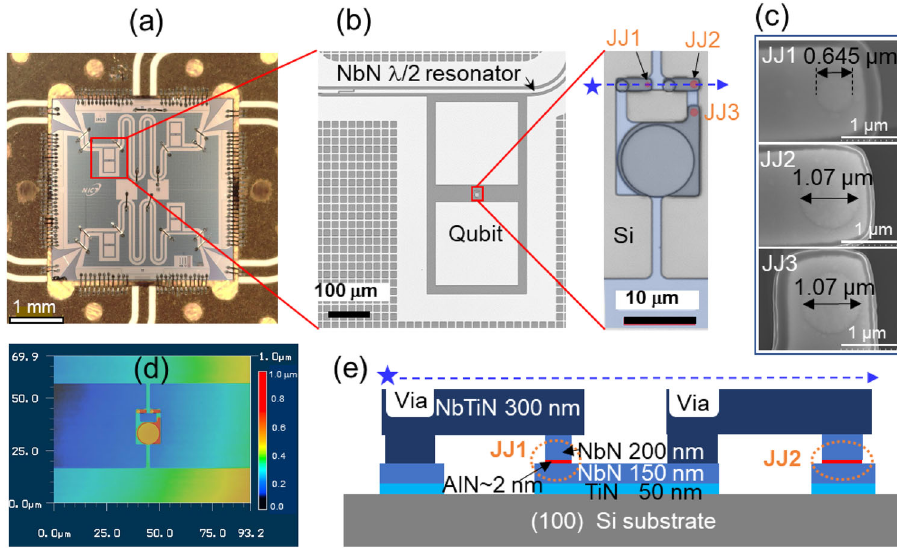
Fig. 1 All-nitride C-shunt fl ux qubit consisting of epitaxially grown NbN/AlN/NbN Josephson junctions on Si substrate. a a photograph of the qubit chip mounted into the sample package, b Laser scanning microscope image of the capacitively shunted fl ux qubit coupled to a half-wavelength ( λ /2) CPW resonator made of NbN/TiN on a Si substrate. The inset shows a magni fi ed image of a false-colored fl ux qubit structure with three NbN/AlN/NbN Josephson junctions (marked as JJ1, JJ2, and JJ3). c Scanning electron microscopy images corresponding to the three JJs taken after the qubit measurements. d The thickness pro fi le of qubit taken from the laser scanning microscope system. The displayed scales are in μ m. e Cross-sectional schematics of the part indicated by the blue star and dashed line in b . The JJ parts are marked by the orange dotted